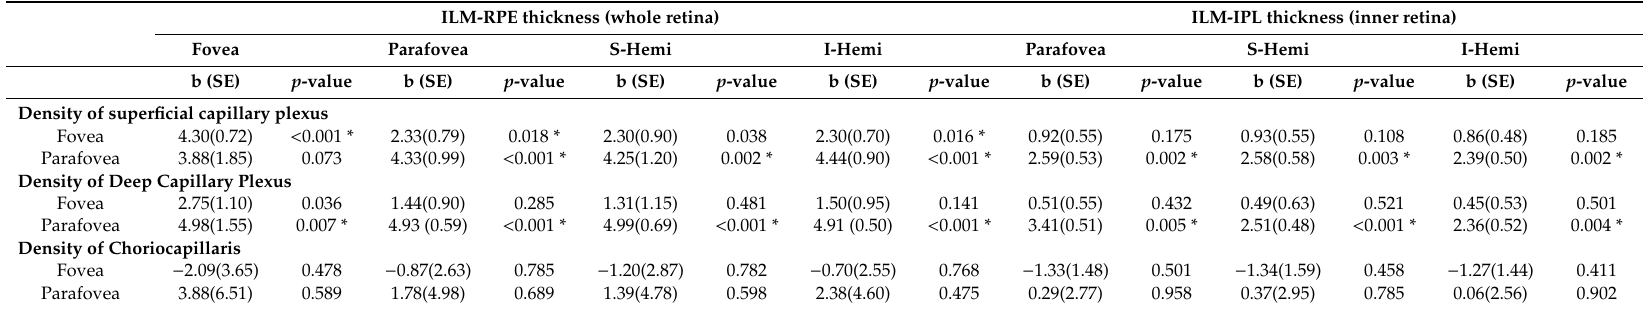
Table 6. Mixed-e ff ects models using the eye as the unit of analysis performed to assess the e ff ect of vascular density on retinal